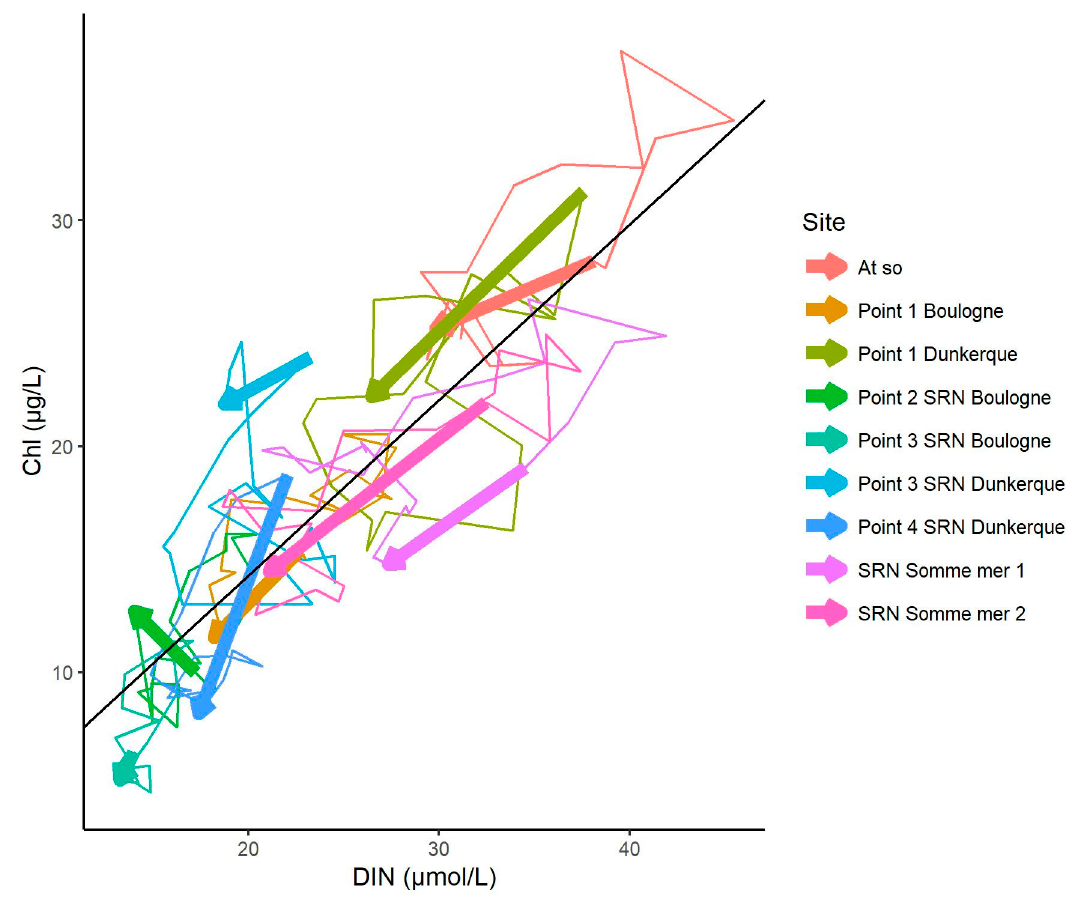
Figure 8. Temporal trajectories of the relationship between Chlorophyll- a (Chl- a ) and Dissolved Inorganic Nitrogen (DIN) concentrations by site and by period (six-year sliding periods between 1994 and 2018). The arrows indicate the overall trajectories (first period to last period). Detailed trajectories are represented by thin colored lines.